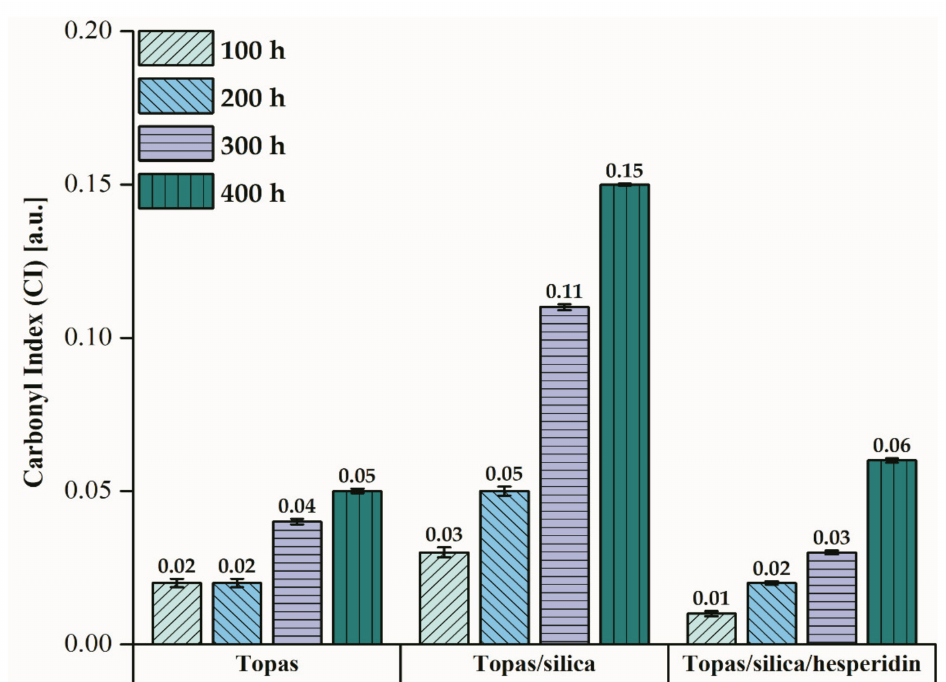
Figure 3. Carbonyl index (CI) values obtained for Topas-based mixtures after weathering, where C=O groups were observed within the 1600–1800 cm − 1 range and CH groups at 2915 cm − 1 ,